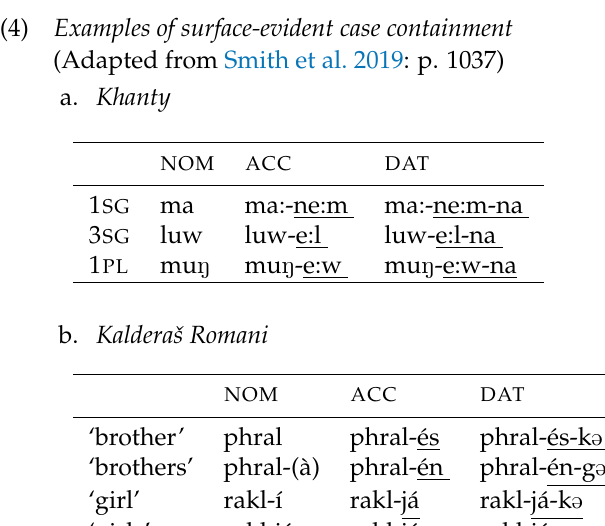
fatima-n 1 fatima- GEN